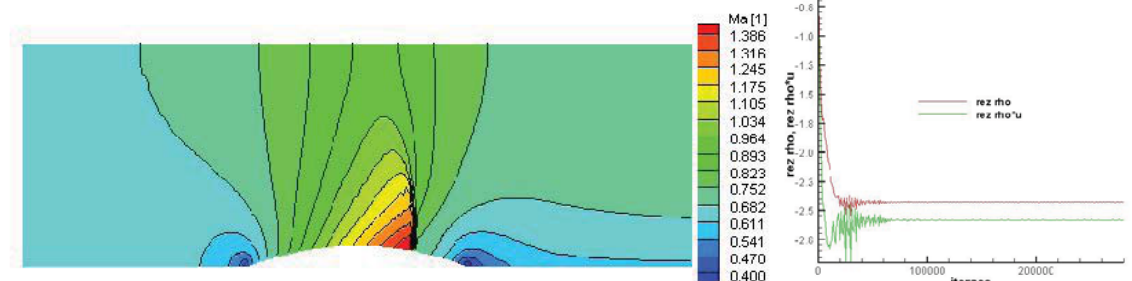
Figure 4: Inviscid compressible flow in the G AMM channel: Mach number isolines (left) and L 2 logarithmic residuals (right) at M 1 = 0 . 675 – LW scheme, IBC B [ M max = 1 . 35 ], a structured non- orthogonal grid with 240 × 50 cells.